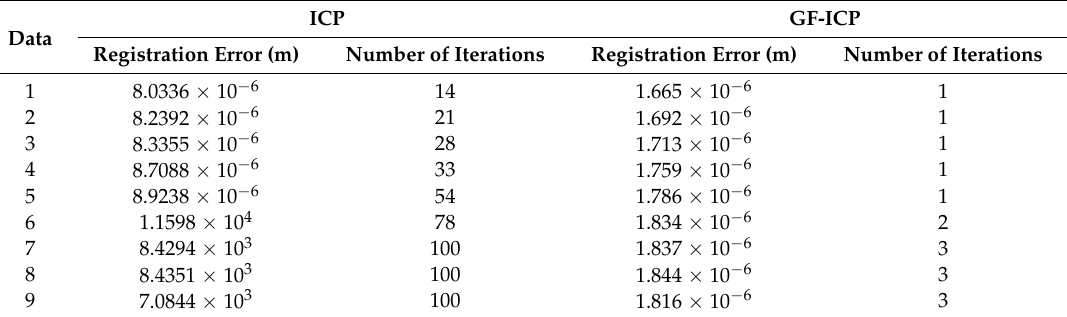
Table 2. Point cloud registration error and the number of iterations required.